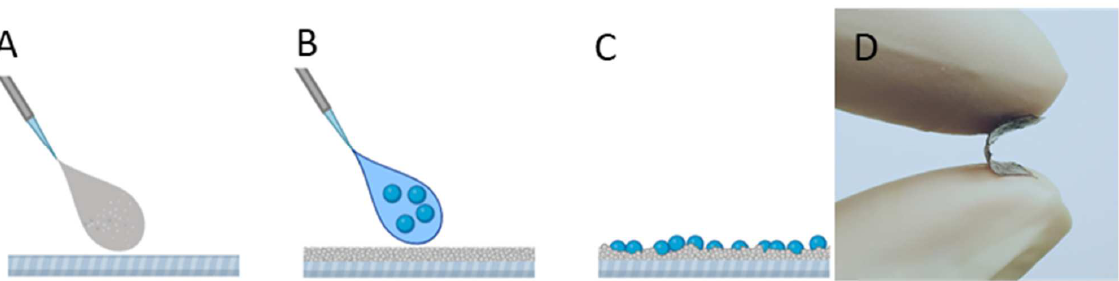
Figure 1. EVA-Ag/AgCl/α-Fe 2 O 3 composite coating preparation scheme: ( A ) EVA polymer spin- coated onto the glass surface and heated for 2 h at 40 °C, ( B ) composite particles in hexane spin- coated onto the EVA coated surface and heated for 2 h at 40 °C, ( C , D ) flexible EVA-coating with interface location of composite particles.